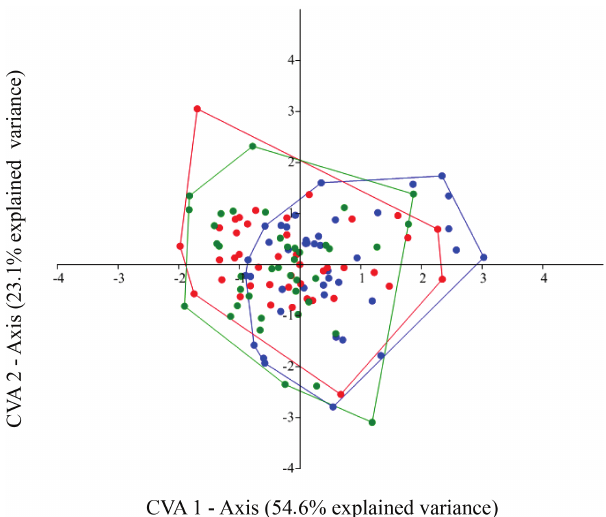
Tab. 1. Summary of descriptive statistics of fish size and otolith asteriscus of Prochilodus nigricans from the rivers Solimões, , fish length ; L Japurá and Negro, Amazon Basin, Brazil. L F O, otolith length; W , otolith width; L , rostrum length; A , otolith O R O area; I , E index; I , R index and C , complexity of the otolith. E R O Fig. 2. Canonical variate analysis of the first 5 PC compo- nents and fish length data of the Prochilodus nigricans for all localities, with 95% confidence. Solimões (blue); Japurá (red) and Negro (green).